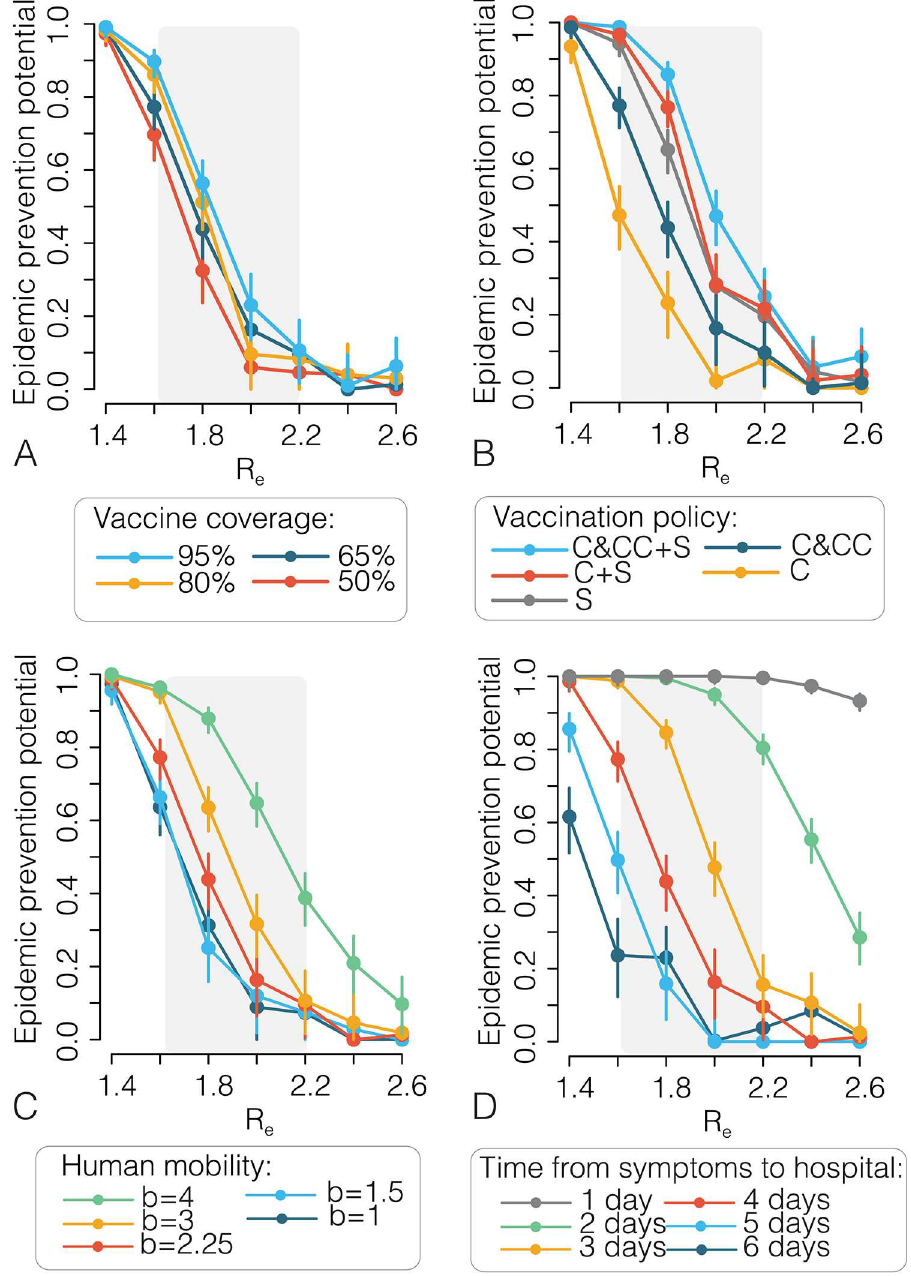
Fig 2. Sensitivity analysis. A Estimated epidemic preventionpotential (points) and 95%CI (vertical lines) as a function of R e and by varying the vaccine coverage. Baseline coverage: 65% [4]. The shadedgrey area represents the range of most plausiblevalues of R e for the 2014–15epidemic in West Africa. B As in A but by varying the eligiblepopulation. Symbols: C indicates contacts of index cases; CC indicatescontacts of contacts; S indicates geographical rings (ring radius: 2 km). Baseline value: C&CC [4]. C As in A but by varying the parameter regulatinghuman mobility. Spatial transmission is proportional to a power law kernel 1/(1 + d b ) where d is the geographicaldistance and b regulates the decrease of transmission with distance. Baseline value: b = 2.25, resulting in an average distance of 7.7 km [23]. Other scenarios assume different values of b , corresponding to an averagedistance rangingfrom 1.5 to 25 km. In these scenarios, probabilities of outbreaksin the absence of interventions were recomputed for each value of the parameter b . D As in A but by varying the time from symptoms onset to hospitalisation. Baselinevalue: 4 days [9]. Each estimate is based on 1,000 simulatedoutbreaks.